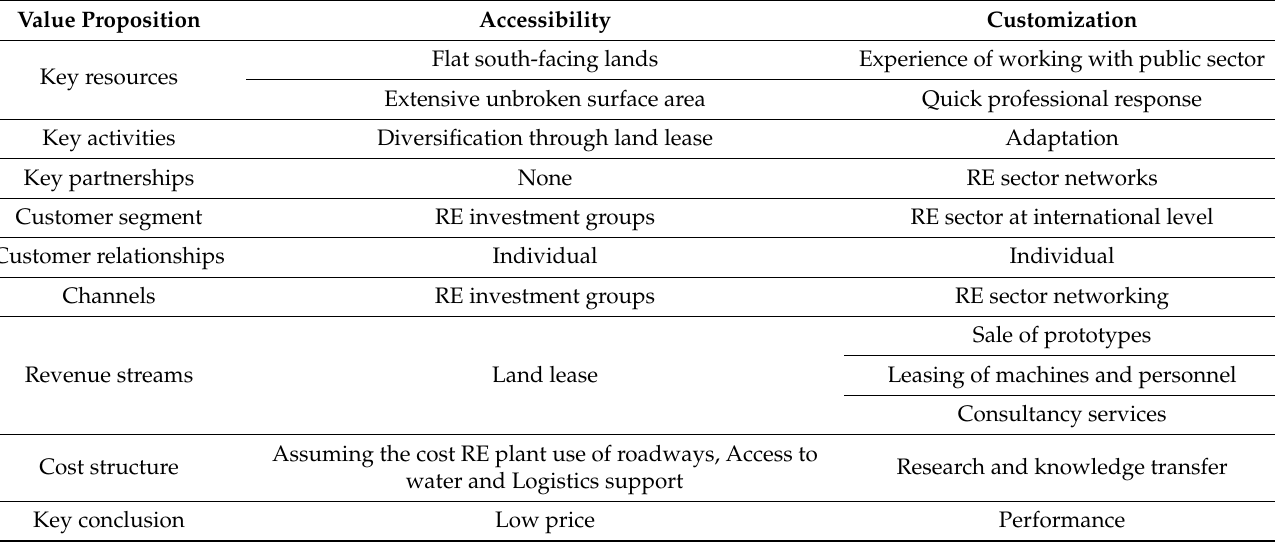
Table 4. Summary of LEAs and their value propositions for the RE